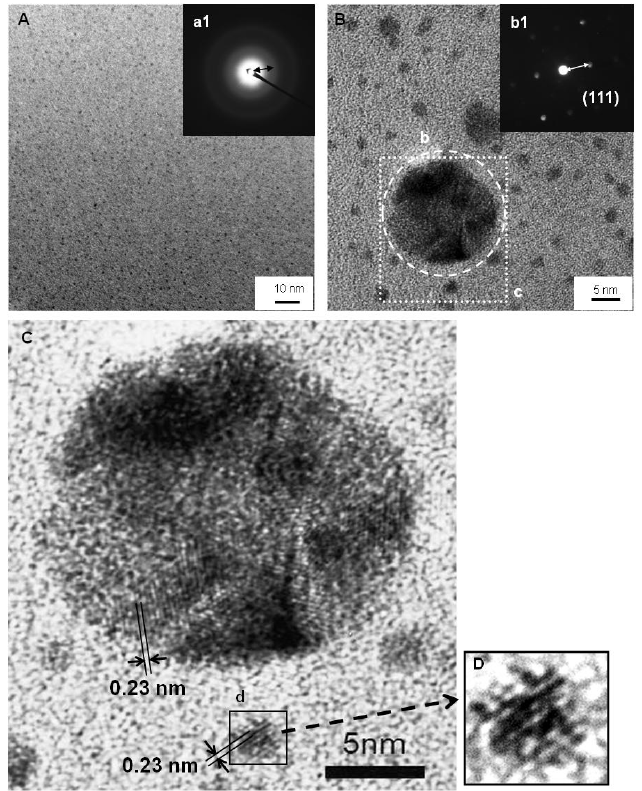
Figure 1. High-resolution field emission transmission electron microscope (FE-TEM) images of the DNA/Ag nanoparticles. The insets in ( A ) and ( B ) show the corresponding selected area electron diffraction pattern (a1) recorded from the whole area ( A ) and the nano-beam diffraction pattern (b1) from the area marked with the dashed line circle (b), respectively. ( C ) and ( D ) are the enlarged images from the areas indicated with the dotted square (c) in ( B ) and with the solid square (d) in ( C ),